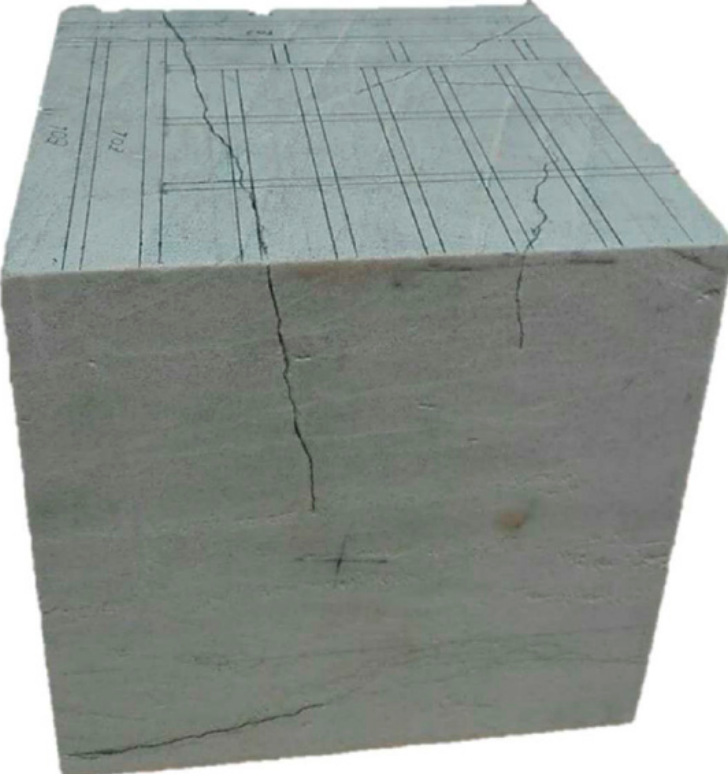
Figure 2. Block of sandstone provided from the Epiroc Rock Drills.